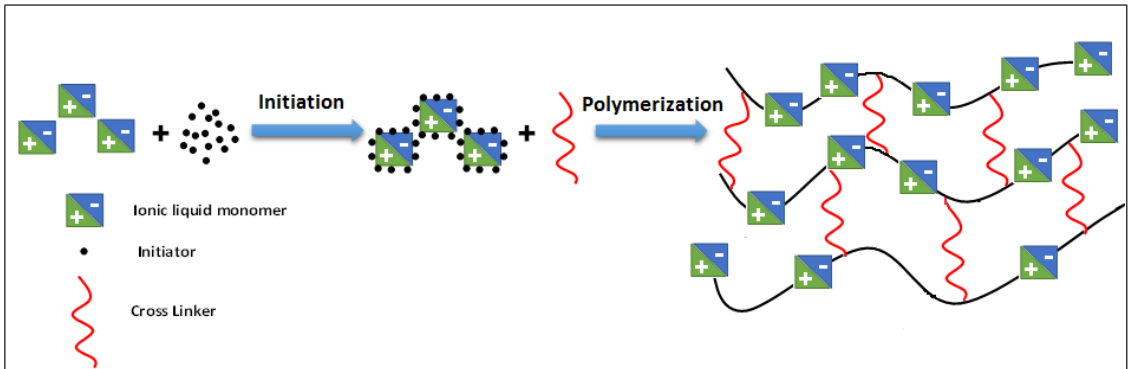
Figure 1. Schematic representation for the formation of the cross - linked poly[veim][Tf 2 N] − TRIM structure.